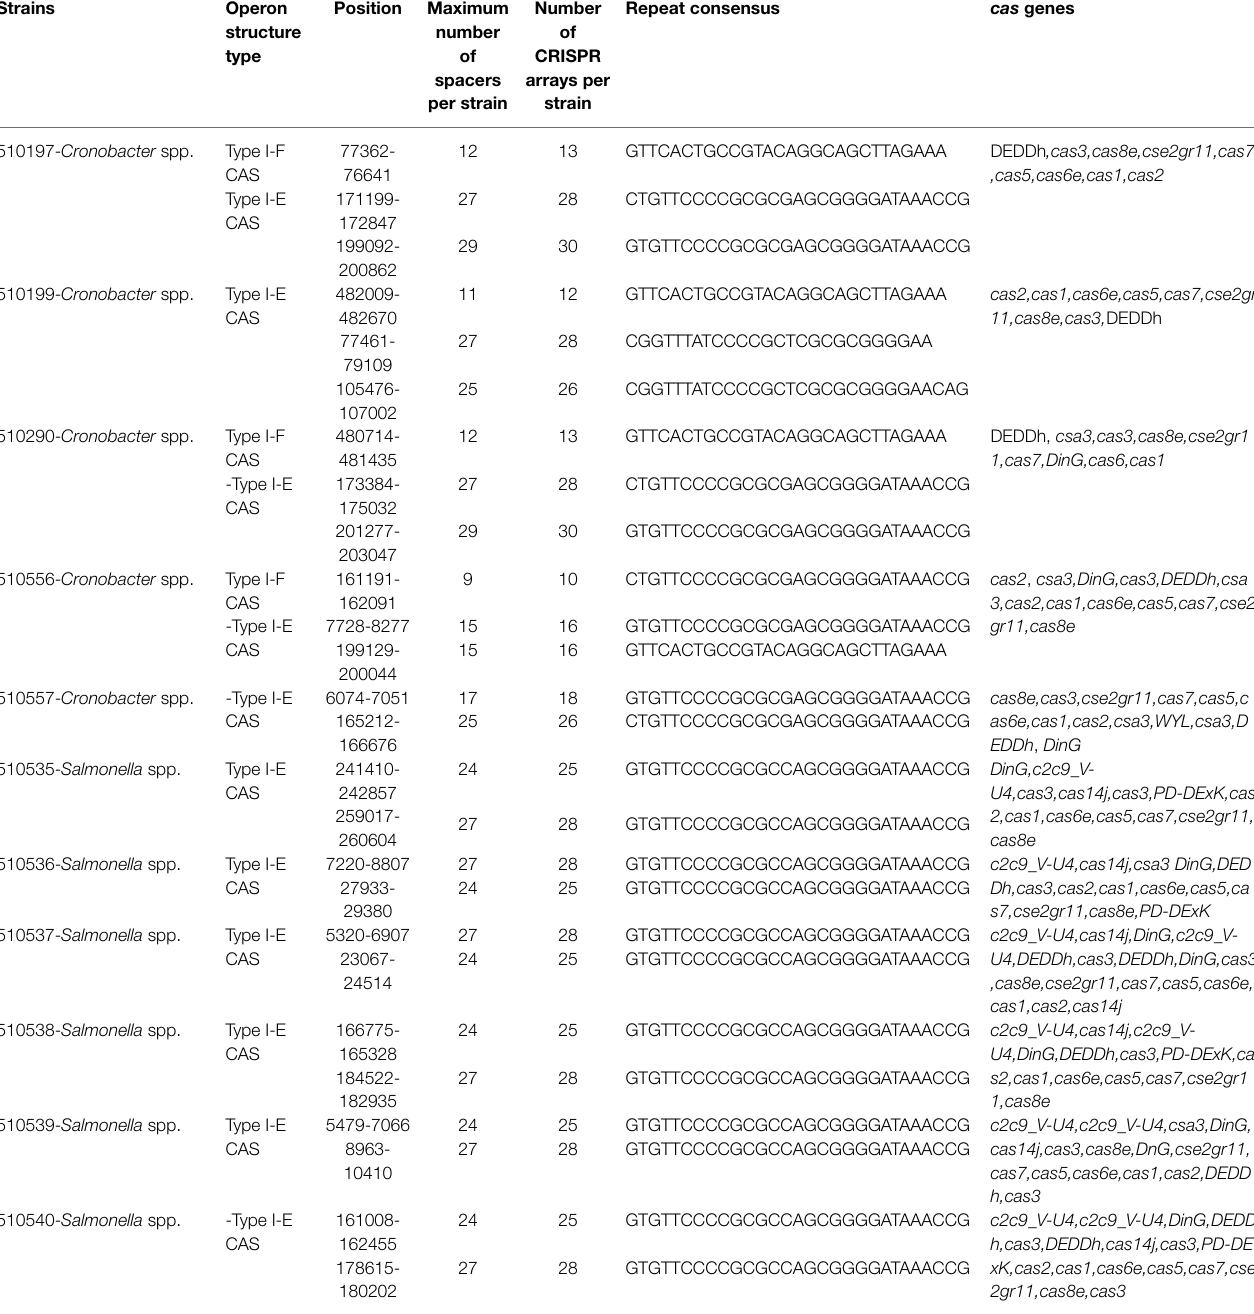
TABLE 8 | CRISPR-Cas systems identified in the Cronobacter spp. and Salmonella spp.